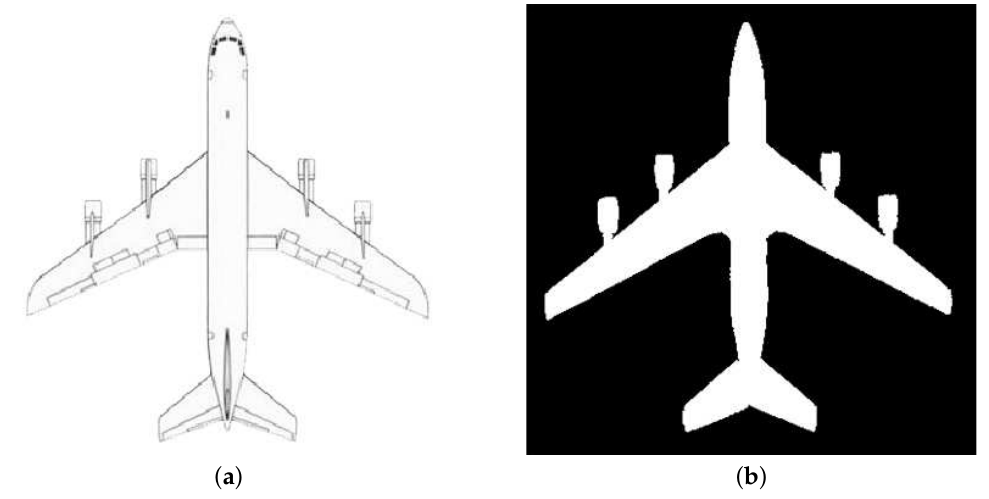
Figure 5. The top-view drawing of an aircraft and its binary shape: ( a ) Top-view drawing of an aircraft, and ( b ) Binary shape of the aircraft in ( a